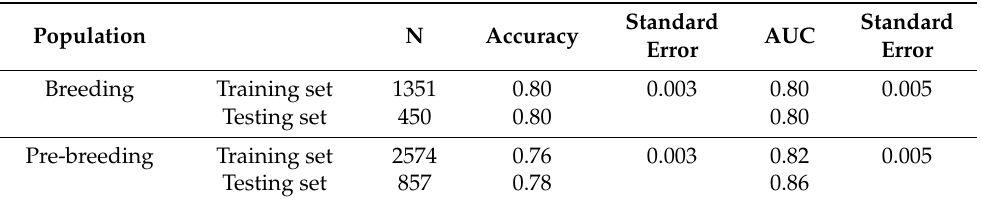
N = number of observations, AUC = area under the curve.